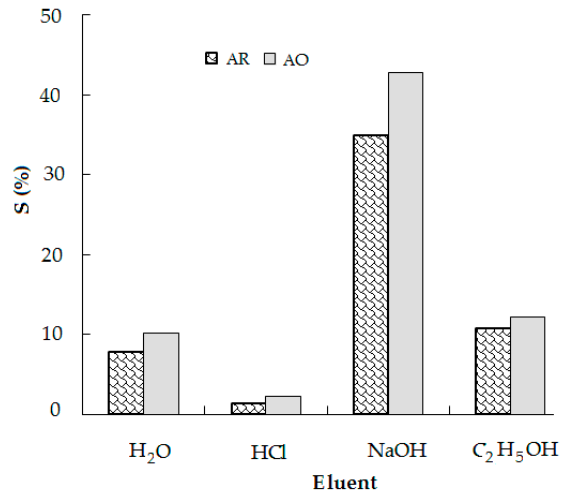
Figure 4. Desorption of the anionic dyes on CS-CP by different eluents.